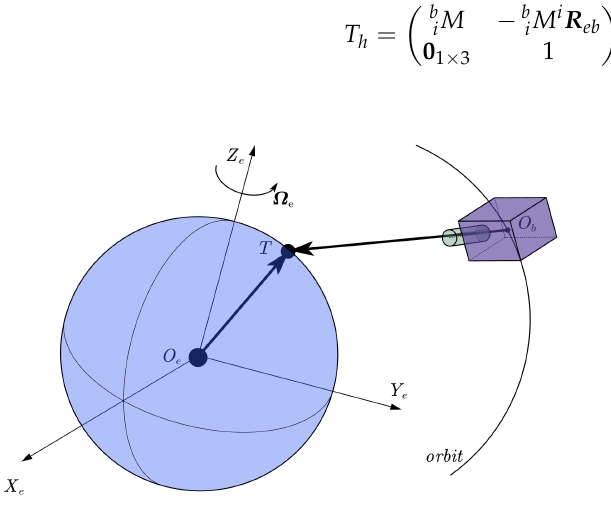
Figure 1. The ground-target-staring observation